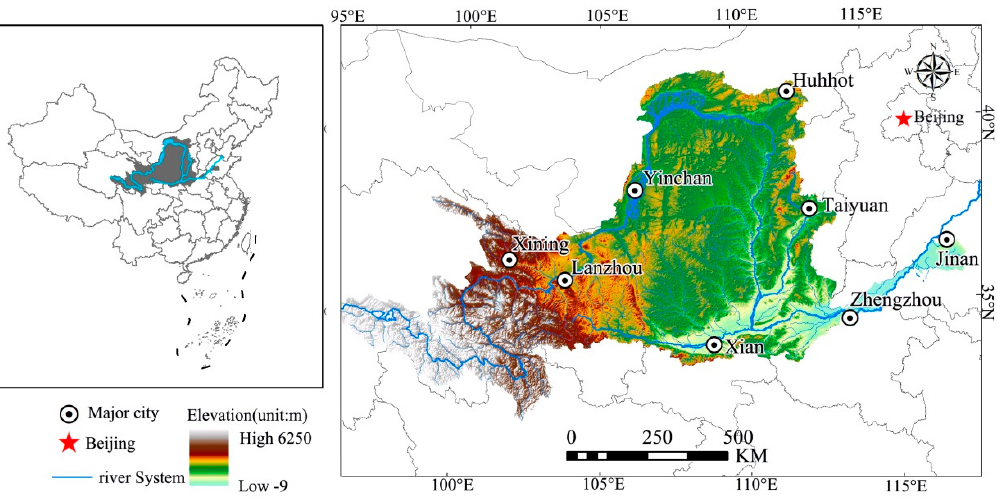
Figure 2. Range of the Yellow River Basin and distribution of the river system.